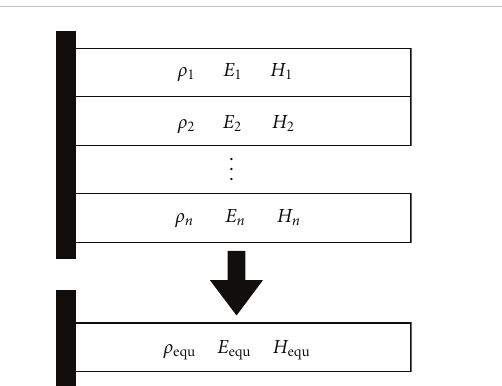
Figure 5: An n-layered T-shaped cantilever and its equivalent monolayered T-shaped